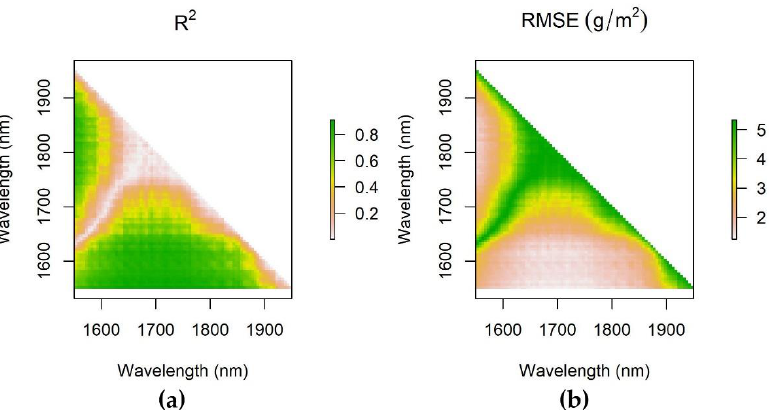
Figure 3. Accuracy metrics for the estimation of equivalent water thickness using normalized ratio indices: ( a ) the mean of coefficient of determination (R 2 ) and ( b ) the mean of root mean square error (RMSE) for each NRI for all four measured leaves after petiole removal. The wavelengths used for calculating each NRI are on x - and y -axis.